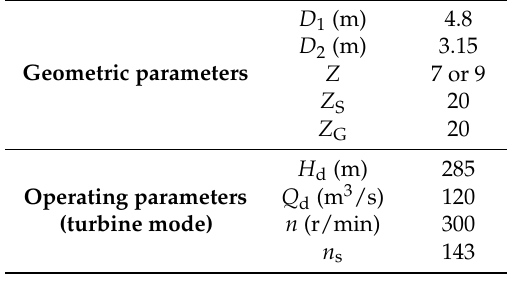
Table 1. Parameters of pump-turbine.